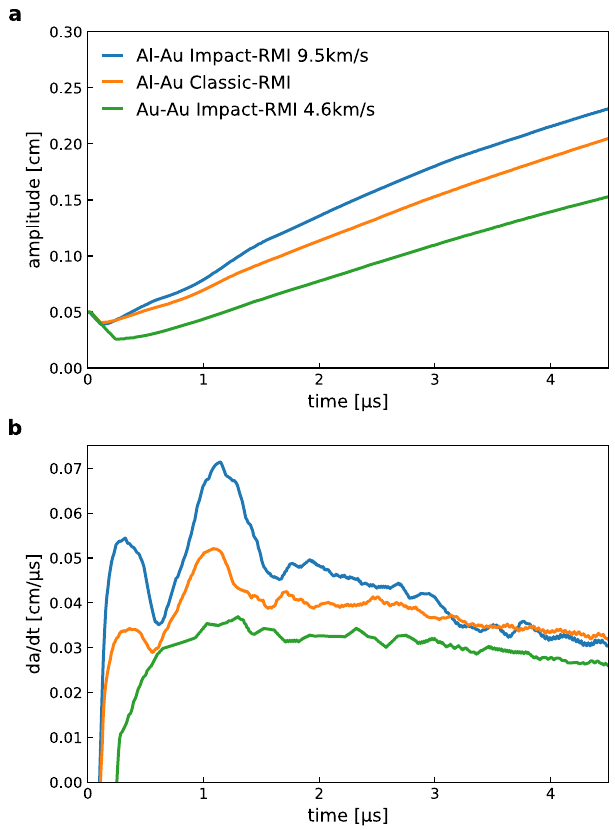
Fig. 4 Interface instability growth. a Amplitude vs. time, a ( t ), for three cases with fi nal pressure of ~300 GPa: Al-Au, interface instability (blue); Al-Au, classical RMI (red); and Au-Au interface instability (green). b Growth rate ( da / dt vs. time) for the same three